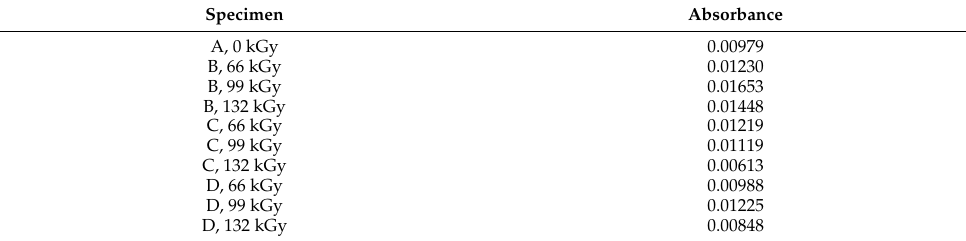
Table 4. Values of absorbance at wavenumber 1736 cm − 1 .